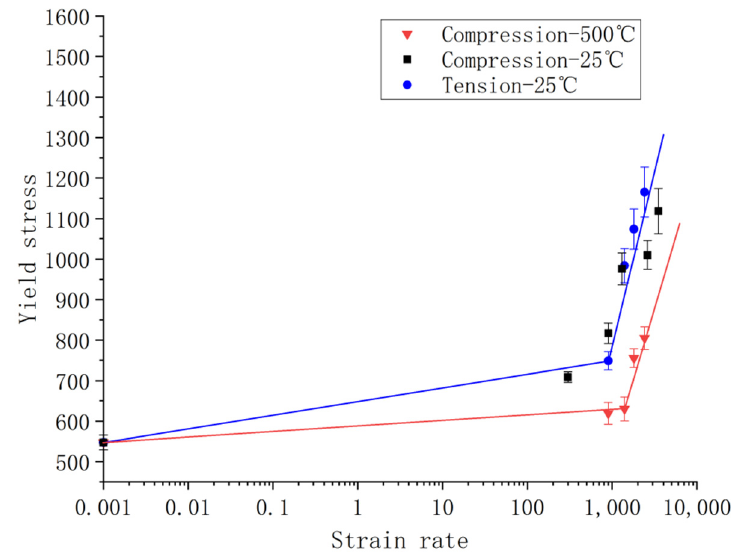
Figure 18. Dynamic yield stress vs. strain rate.